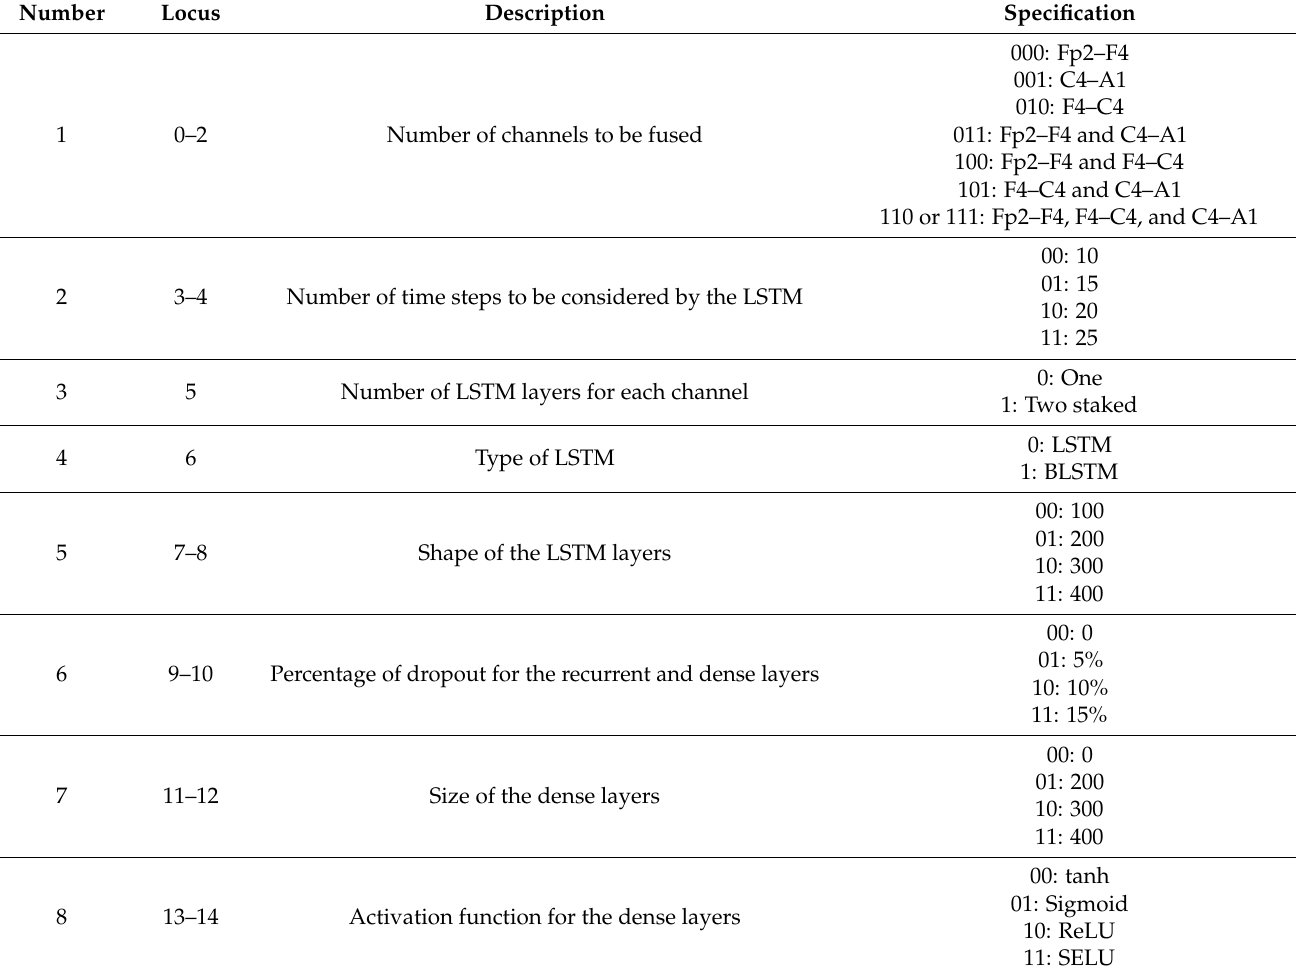
Table A1. Encoding array examined by the optimization